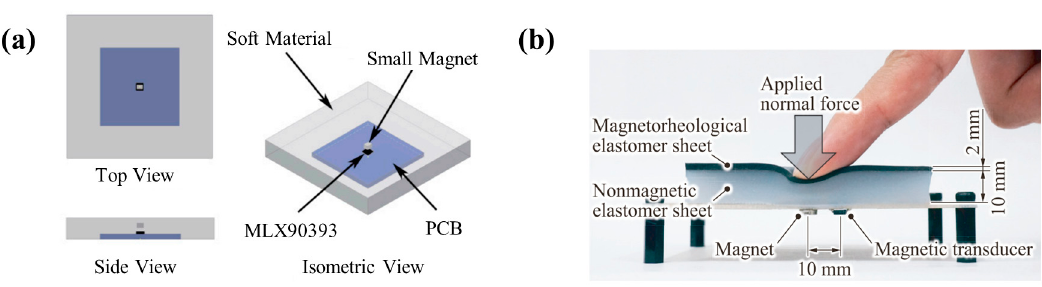
Figure 11. ( a ) Tactile sensor using a film with a permanent magnet in the center. Reprinted with permission from Ref. [44]. Copyright 2016, MDPI; ( b ) Tactile sensor using a film with magnet particles. Reprinted with permission from Ref. [67]. Copyright 2018, MDPI.